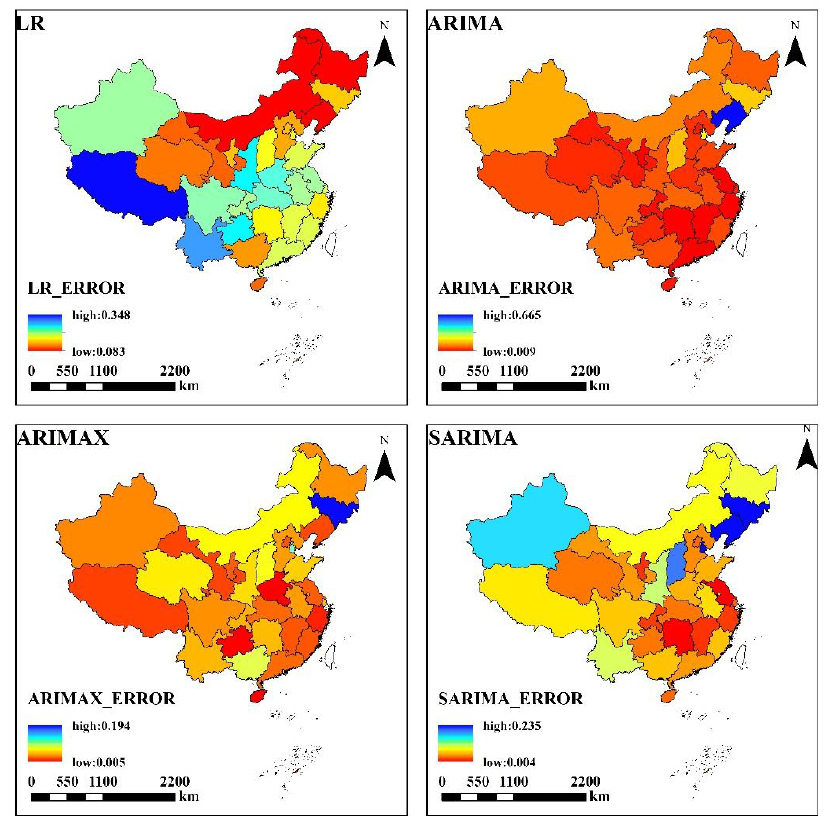
Figure 10. The comparison of the average error of the different GDP forecast models in China.